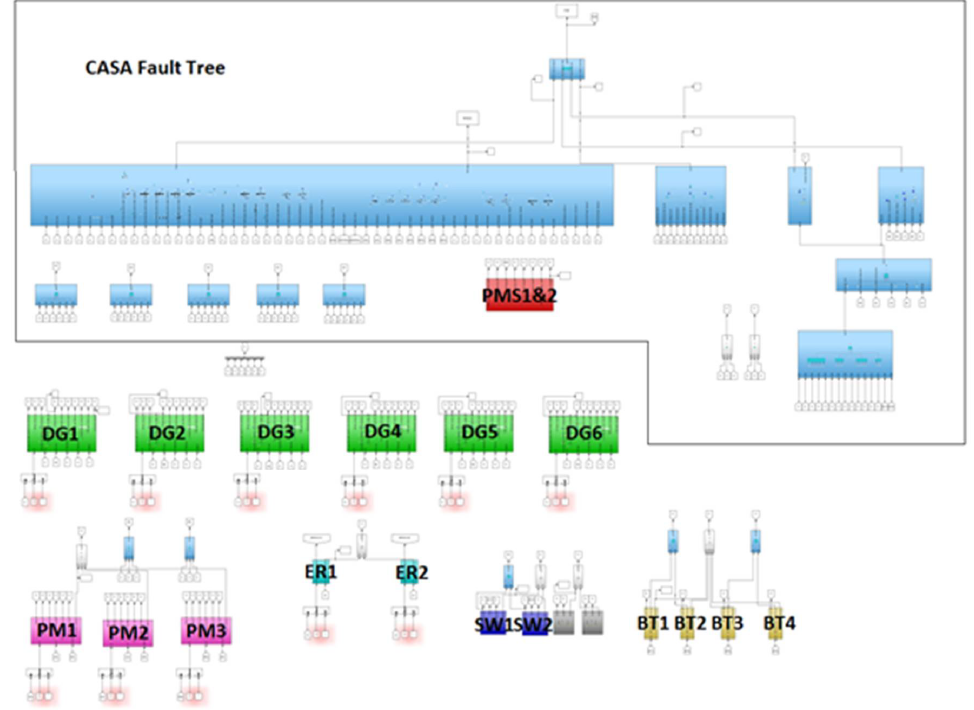
Figure 3. Cruise ship Fault